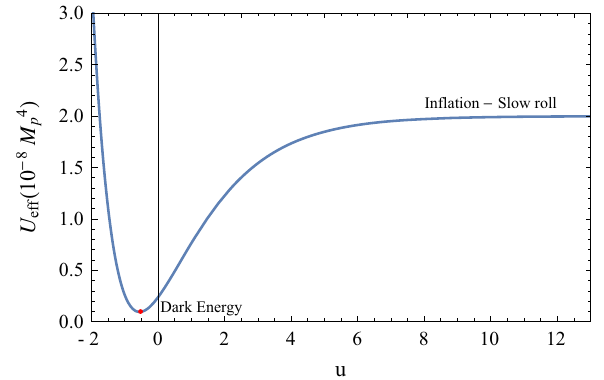
Fig. 1 Qualitative shape of the effective potential U eff ( u ) in the Ein- stein frame, as presented in Eq. (19). The physical unit for u is √ M Planck /